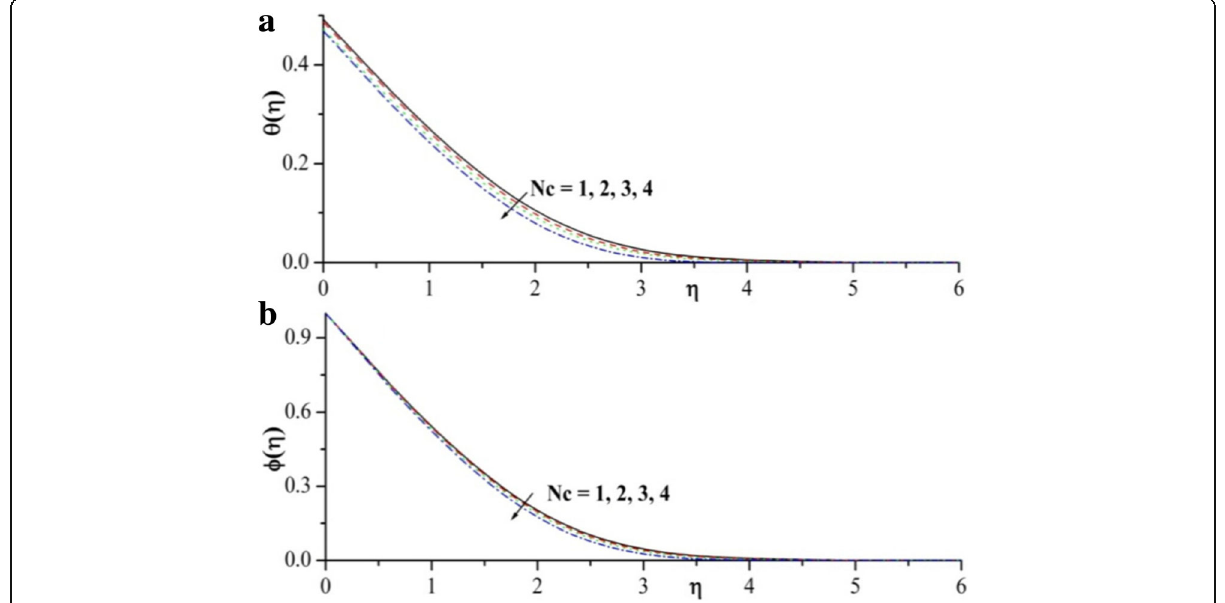
Fig. 3 a Temperature and b nanoparticle concentration profiles for variable values of